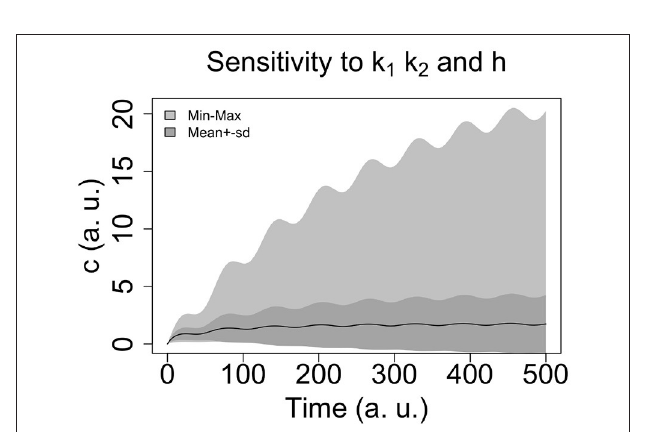
FIGURE 4 | The value of objective function j rapidly decreases as k 2